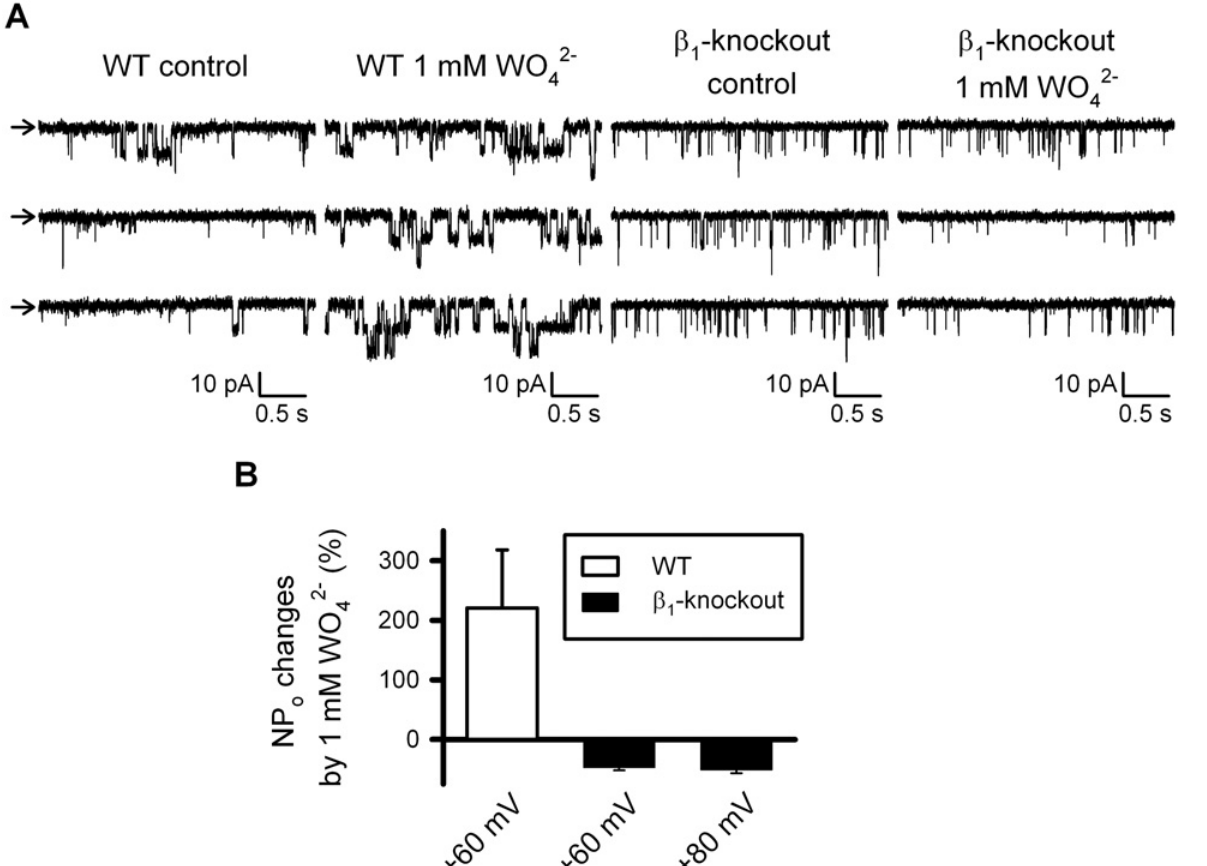
Fig 4. Tungstate-induced increase in the open probability of BK channels endogenously expressed in freshly isolated vascular myocytes requires the BK channel β 1 subunit. (A) Representative recordings obtained from inside-out patches clamped at + 60mV from wild-type (WT) and β 1 - knockout freshly isolated mouse vascular myocytes, before (control) and after exposure to 1 mM tungstate (1 mM WO 42- ), as stated. Arrows indicates the closed state level. (B) Average changes (in %) of BK channel open probability (NP o ) induced by 1 mM tungstate on WT and β 1 - knockout mouse vascular myocytes at the indicated voltage membrane. Significant differences were found among WT (n = 7) and β 1 - knockout (n = 9), P < 0.001 (Student ’ s t-test). Further depolarization to +80 mV of β 1 - knockout inside-out patches did not change the response to tungstate found at +60